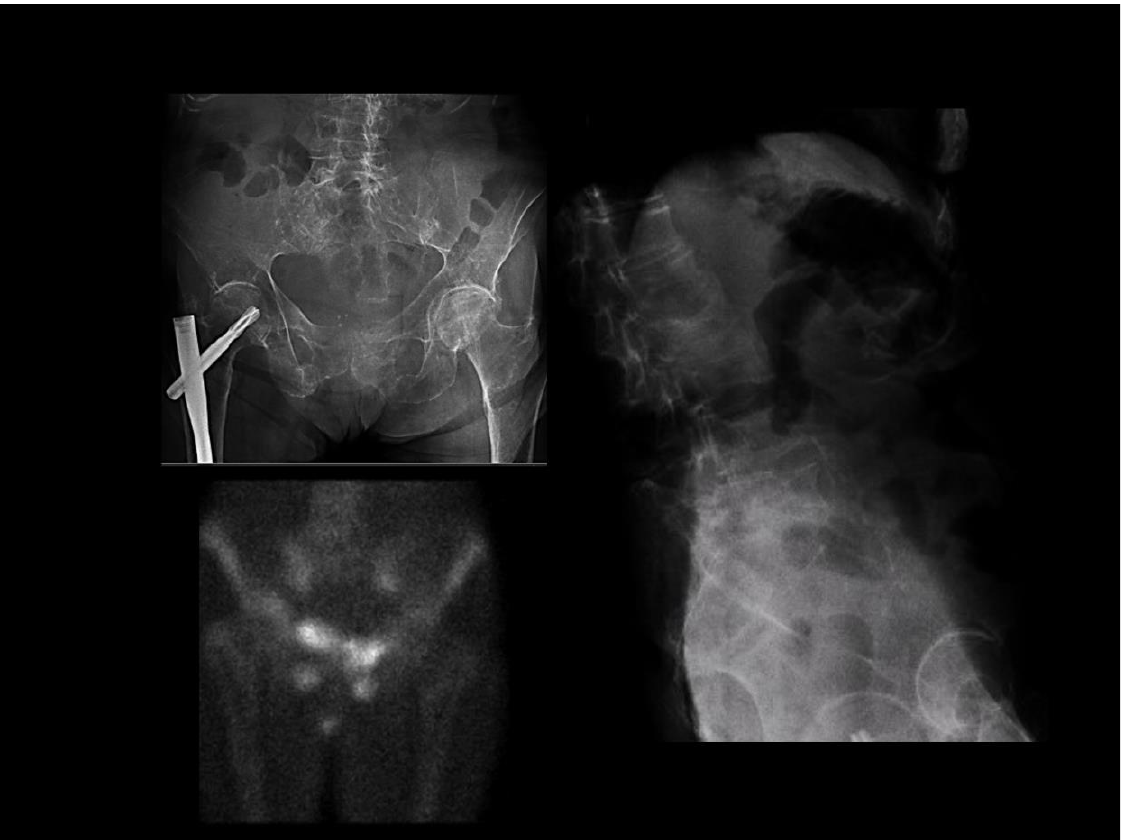
Figure 2. Multiple bone-insufficiency fractures in a patient with osteomalacia. Left upper part: fracture of the right hip (with surgical osteosynthesis) and pubic rami. Right side: multiple vertebral fractures. The lower-left picture shows a scintigraphic image consistent with fractures of the ilio and ischiopubic rami.